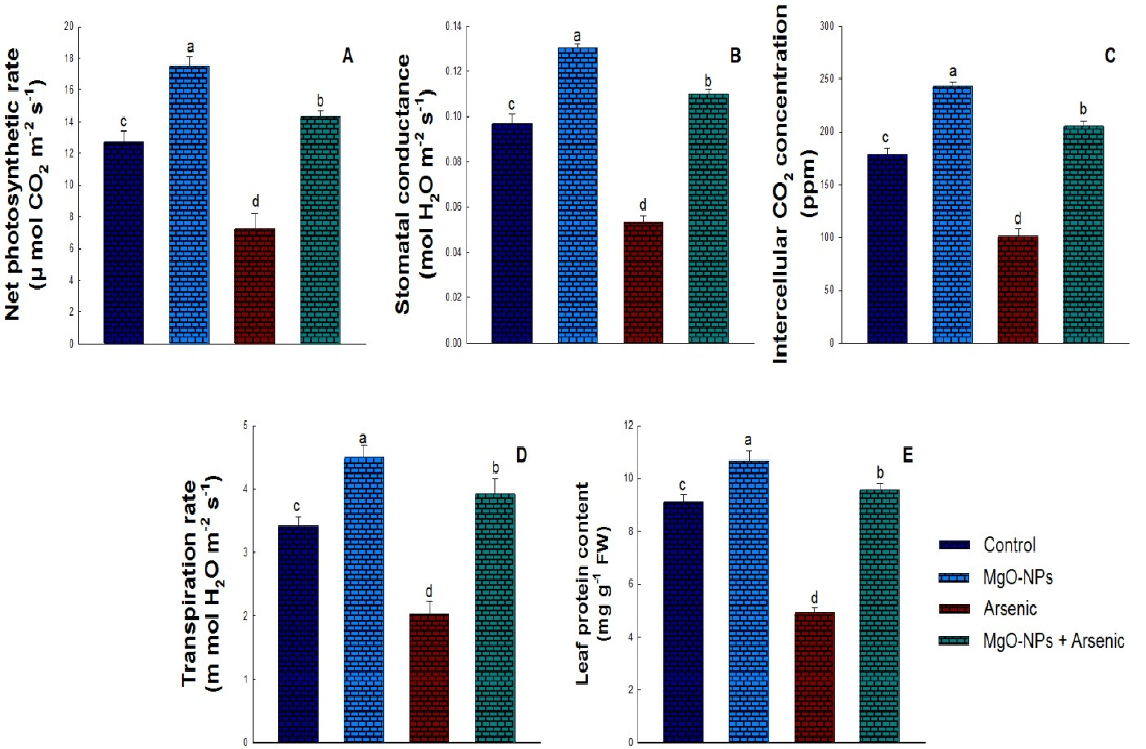
Figure 2. Net photosynthetic rate (P N ) ( A ), stomatal conductance (gs) ( B ), internal CO 2 concentration (Ci) ( C ), transpiration rate (E) ( D ) and leaf protein content ( E ) of soybean plants before and after foliar spray with MgO-NPs in the presence/absence (control) of As. Error bars represent standard deviation and different letters indicate significant differences at p < 0.05.